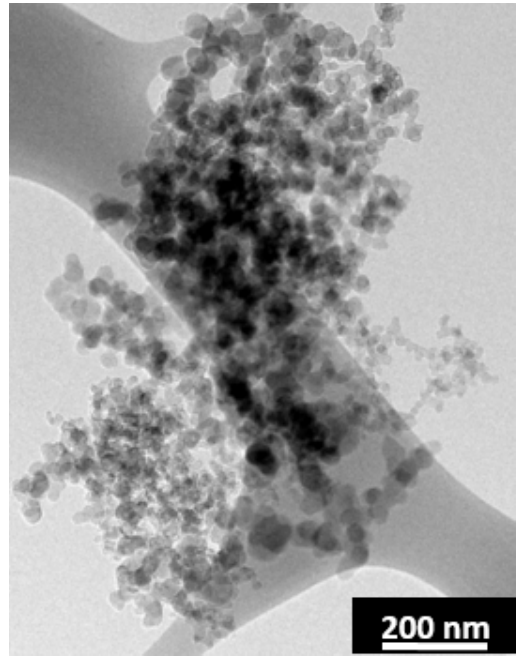
Figure 7. TEM micrographs of Swiss-Cheese-Graphite formed from CO 2 laser annealing of anthracene-fluorene coke.